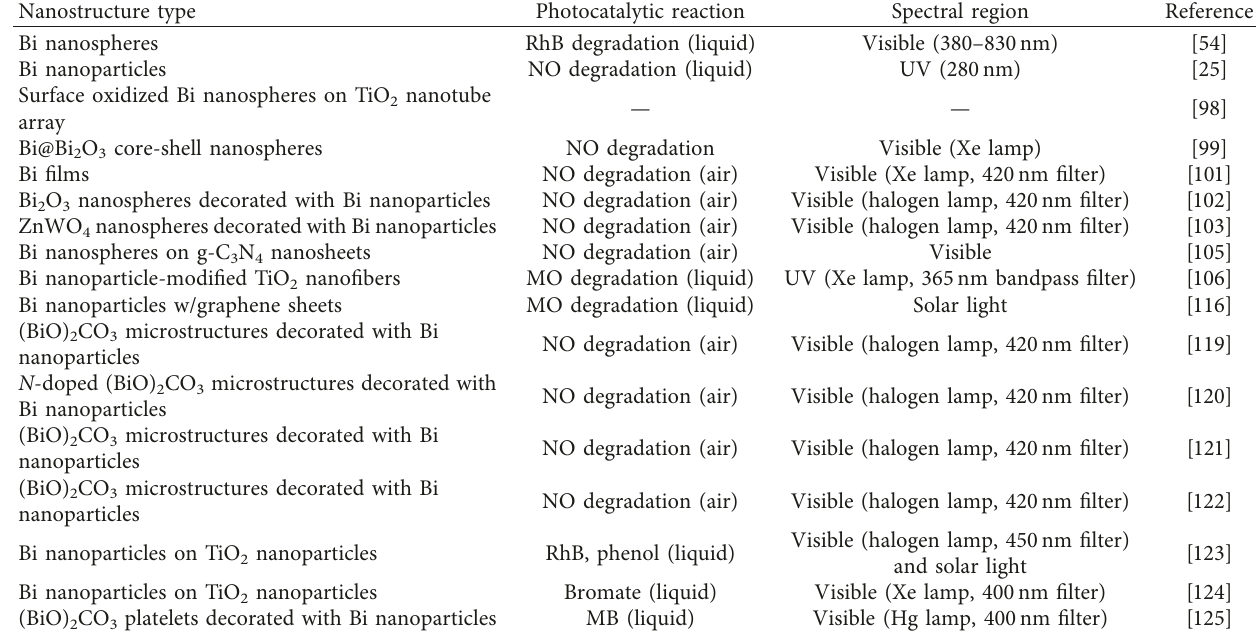
Table 2: Bi-based photocatalysis on selected